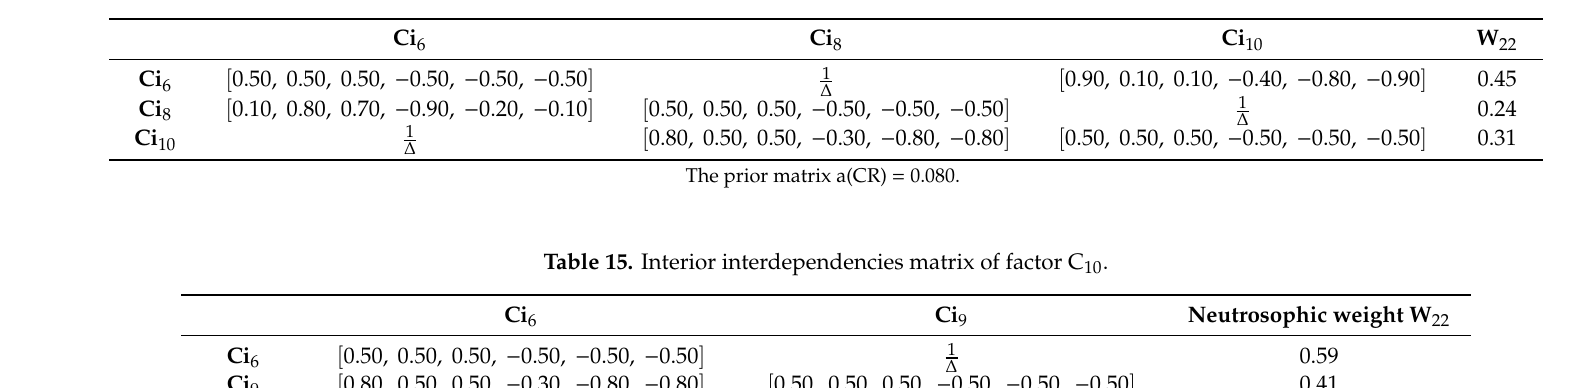
Table 14. Interior interdependencies matrix of factor C 9 .